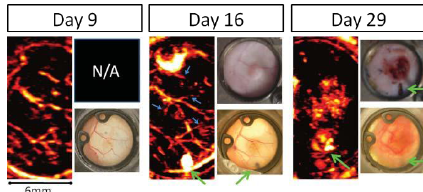
Fig. 4. Optical and PA imaging of the progression of an implanted tumor in a mouse model. Photographs (6 (cid:2) 6 mm) of window chamber's skin side (top right) and coverslip side (bottom right) are shown alongside the PA image (left, (cid:2) ¼ 800 nm, 6 (cid:2) 12 mm). PA images on days 9 and 16 revealed a map and progression of the vascular network. The PA signal for day 29 is largely dominated by the extensive hemorrhage, which is consistent with the skin side photograph. Blood vessels are clearly resolved in the PA image on day 16 (labeled with small blue arrows), but not visualized in the skin side photo- graph. The large green arrows denote the ¯ducial ink